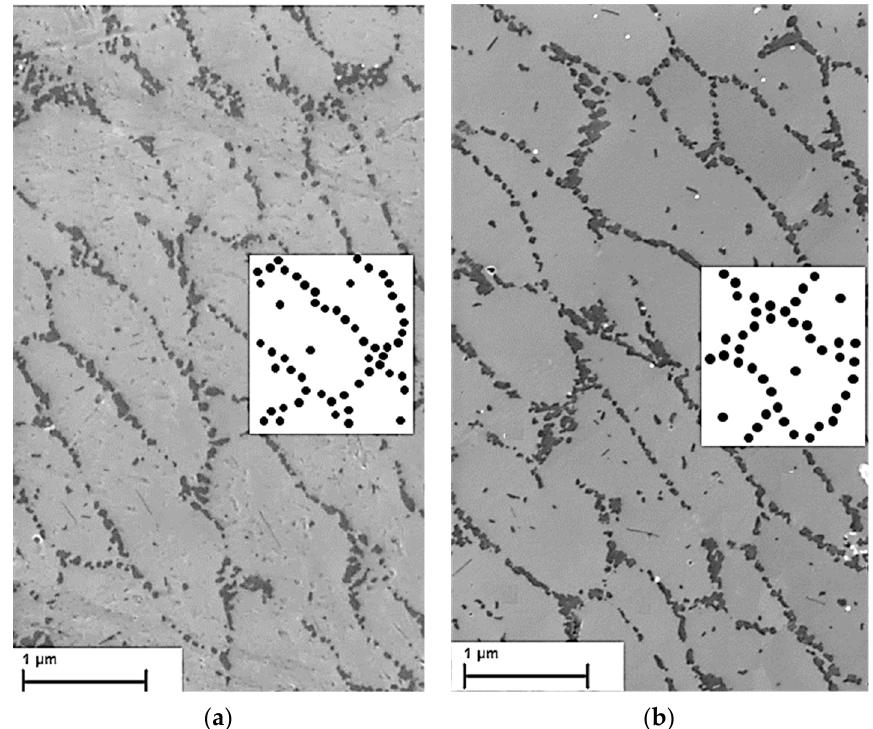
Figure A2. Comparison between the calculated particle size (the black circles in the insert, which qualitatively show the microstructure of the model material) and the real structure after annealing for 30 h. The diameter of the black circles in the inserts corresponds to the calculated particle size at the given magnification. ( a ) 175 °C, calculated size of Si particles = 53 nm; ( b ) 200 °C, calculated size of the particles = 63 nm.